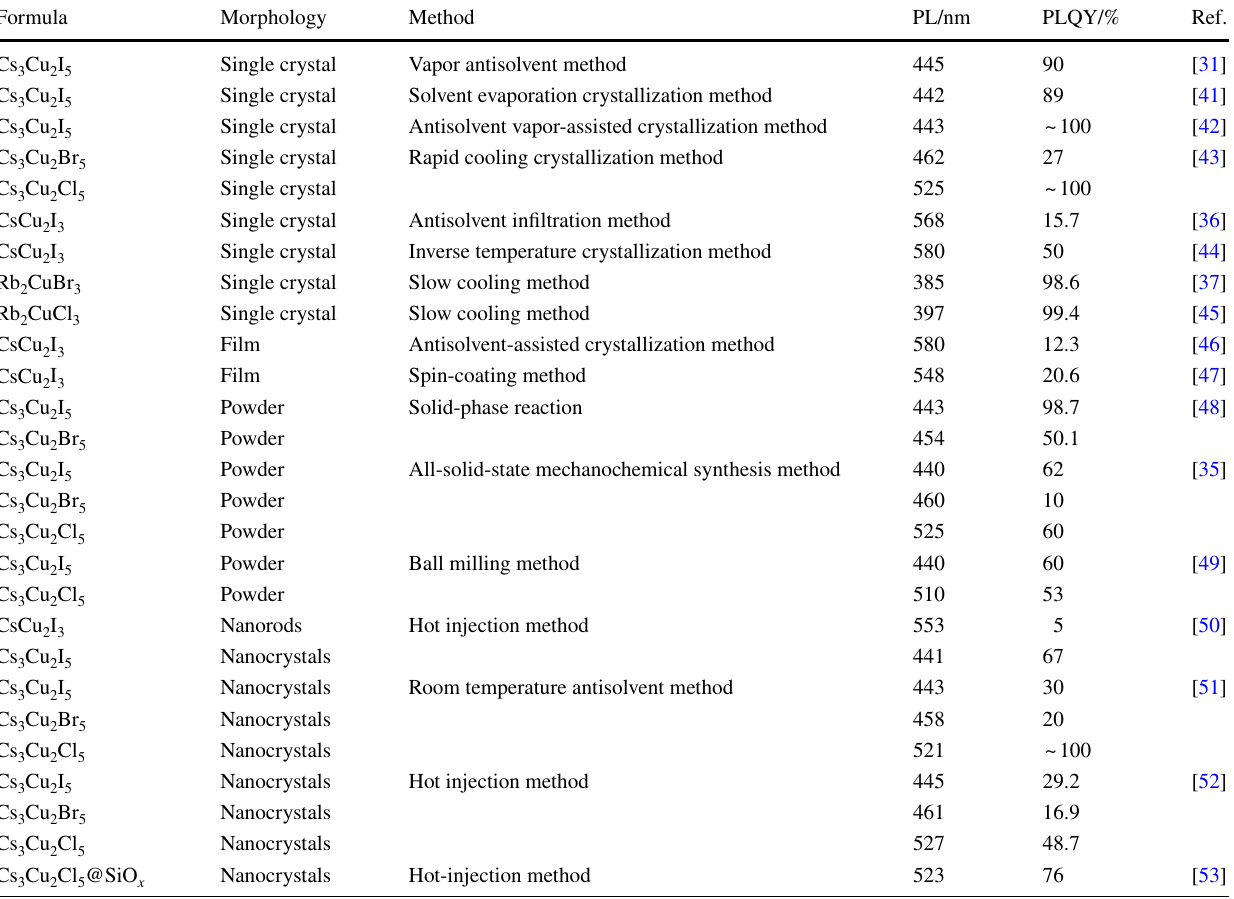
Table 1 Summary of optical parameters of copper-based metal halides